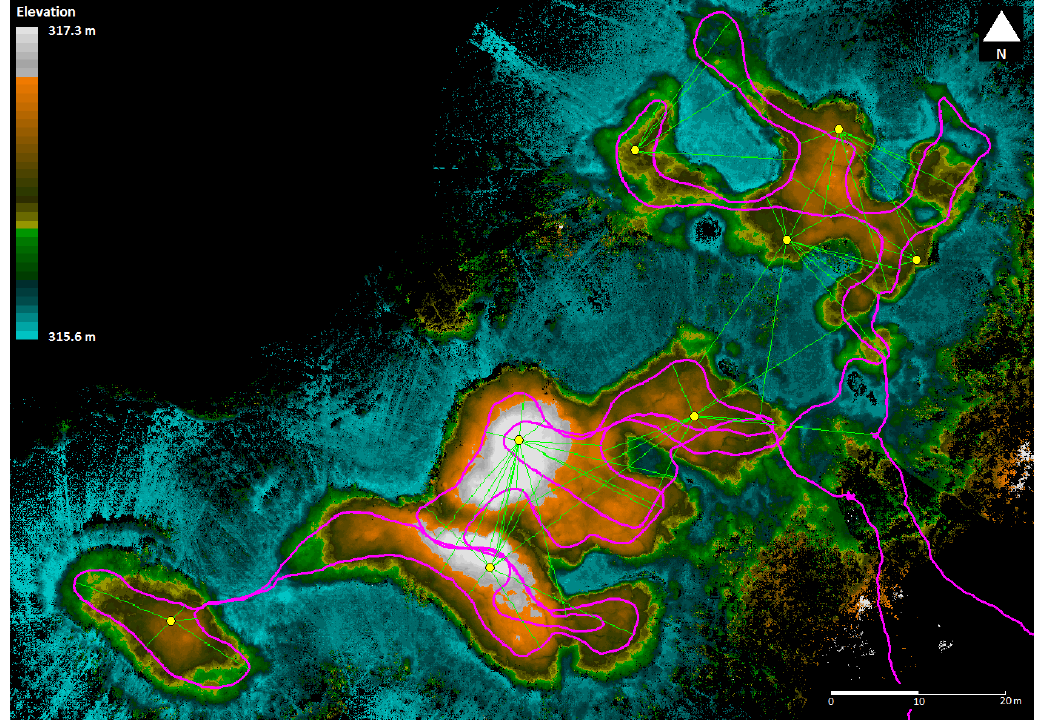
Figure 14. Assessing MLS data accuracy with spherical targets (red circles).